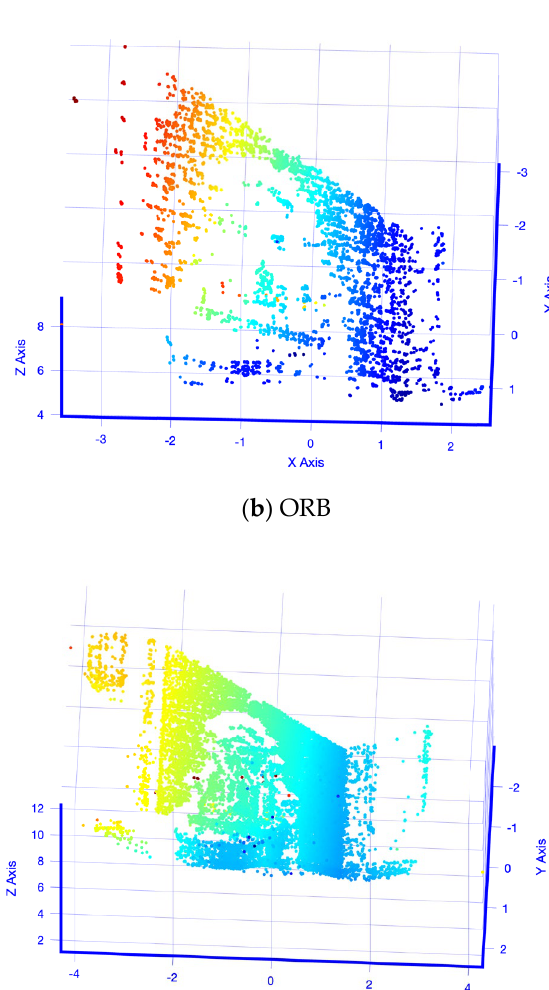
Table 6. The features accumulation and contribution to the point cloud of EPFL dataset applied.